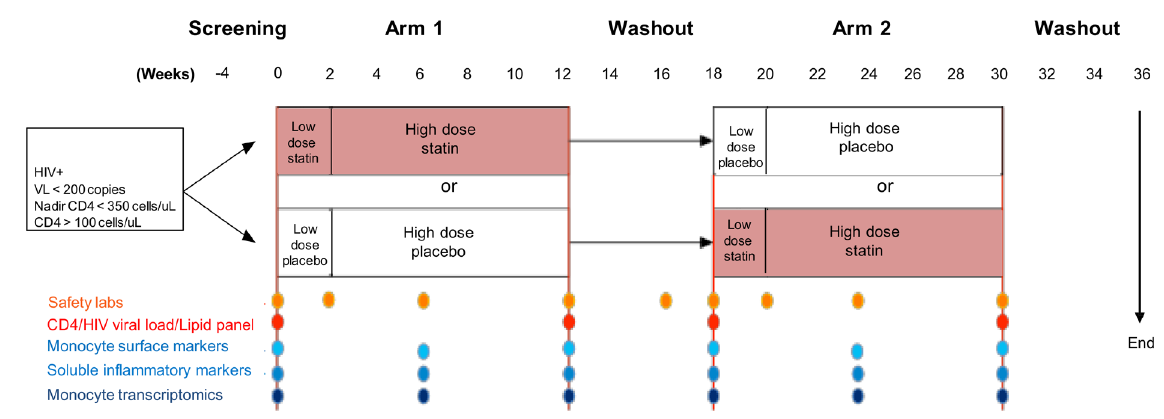
Figure 1. Schematic of study treatment and analysis plan